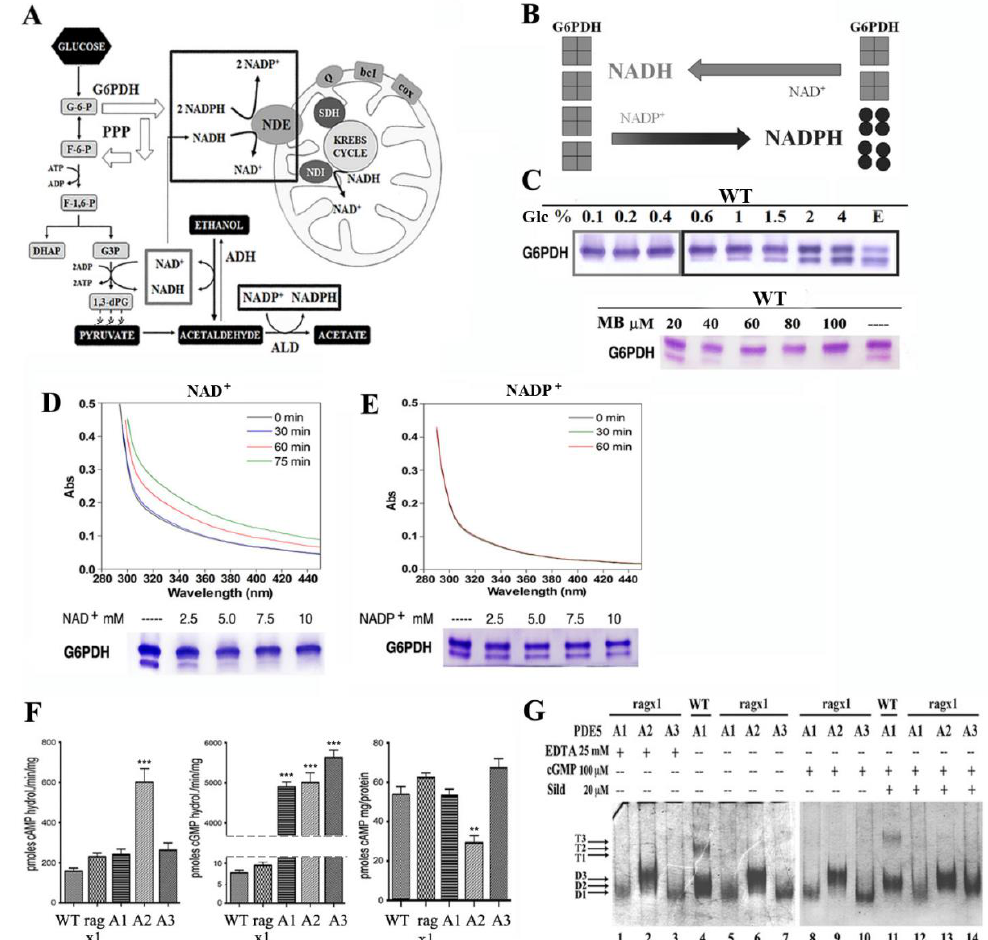
Figure 3. Role of the coenzymes NAD(P) + /NAD(P)H in the onset of fermentation in the K. lactis WT strain, quantification of cyclic nucleotide PDE activity, cAMP content and effects of the ragx1 mutation on the quaternary structure of MmPDE5 isoforms. ( A ) Schematic summary of the role of NAD + vs. NADP + during the glycolytic–fermentative metabolism, their implication in the pentose phosphate pathway (PPP), their oxidation by NDE1 (which has higher affinity for NADH than for NADPH). ( B ) A model showing the opposite role of the coenzymes on the assembly and activity of G6PDH ( C ) Effect of cytosolic NAD(P)H on G6DPH isoforms during the respiratory to fermentative transition (from Glc 0.1% to 4%; E stands for Ethanol). Effect of NADPH oxidation by MB during fermentation (YP + 2% Glc) on G6PDH isoforms. ( D ) Absorbance spectra and G6PDH content of WT cell extracts supplemented with increasing concentrations of NAD + (up to 10 mM). ( E ) Absorbance spectra and G6PDH content of WT cell extracts supplemented with increasing concentrations of NADP + (up to 10 mM). ( F ) Extracts from 10 mL cultures of ragx1, WT, MmPDE5A1 (A1), MmPDE5A2 (A2), and MmPDE5A3 (A3) transformed strains grown to early stationary phase were used to determine the cAMP hydrolyzing activity (left panel), cGMP hydrolyzing activity (center panel) and cAMP content (right panel). Reported values are the means from three independent determinations (S.D. was always between 2% and 12%). Student’s t -test was used to determined statistical significance with respect to WT: ** p < 0.01; *** p < 0.001 ( G ) Quaternary assembly of recombinant MmPDE5A isomers produced in the ragx1 mutant. Native PAGE pattern of purified MmPDE5A1, MmPDE5A2, and MmPDE5A3 stained with Coomassie (~1.0 µ g). Legend as in Figure 1C,D. MmPDE5A1 protein purified from the WT strain has been loaded as a control. Native page analyses of MmPDE5 isoforms under different conditions/incubations are the means of at least three independent experiments. One representative gel is shown in the